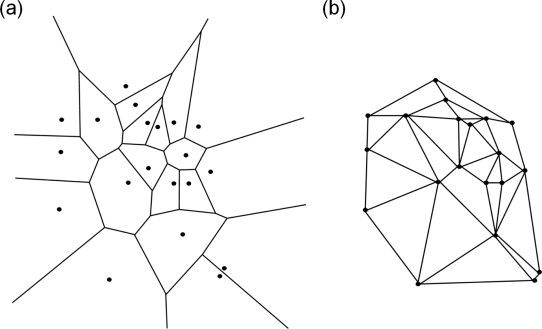
(a) Voronoi diagram of N=20 sites. For a finite set of generator points
T ⊂
Td the Voronoi diagram maps each p ∈
T onto its Voronoi region R(p) consisting of all x ∈
Td that are closer to p than to any other point in
T. (b) Delaunay triangulation for the sites in (a).